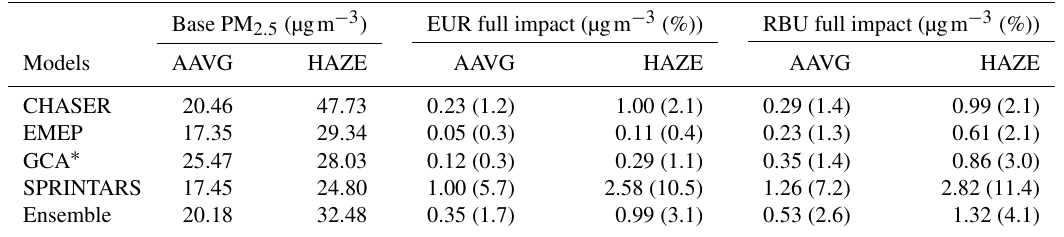
Table 3. Long-range transport full impacts on an annual average scale and during the haze episodes. Numbers in the parentheses indicate the percentage